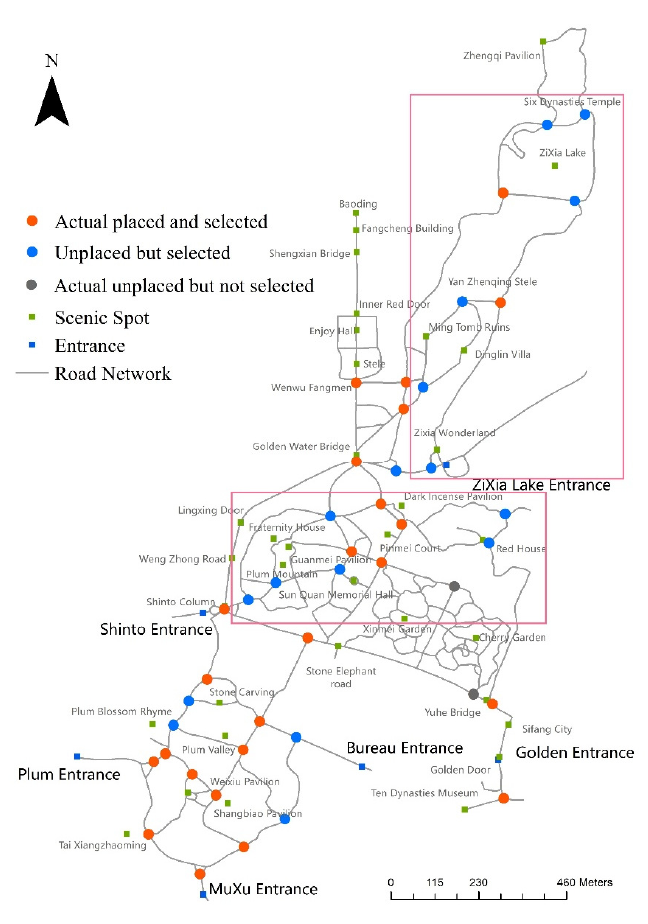
Figure 10. The comparison of the actual placement scheme and the result in this paper .